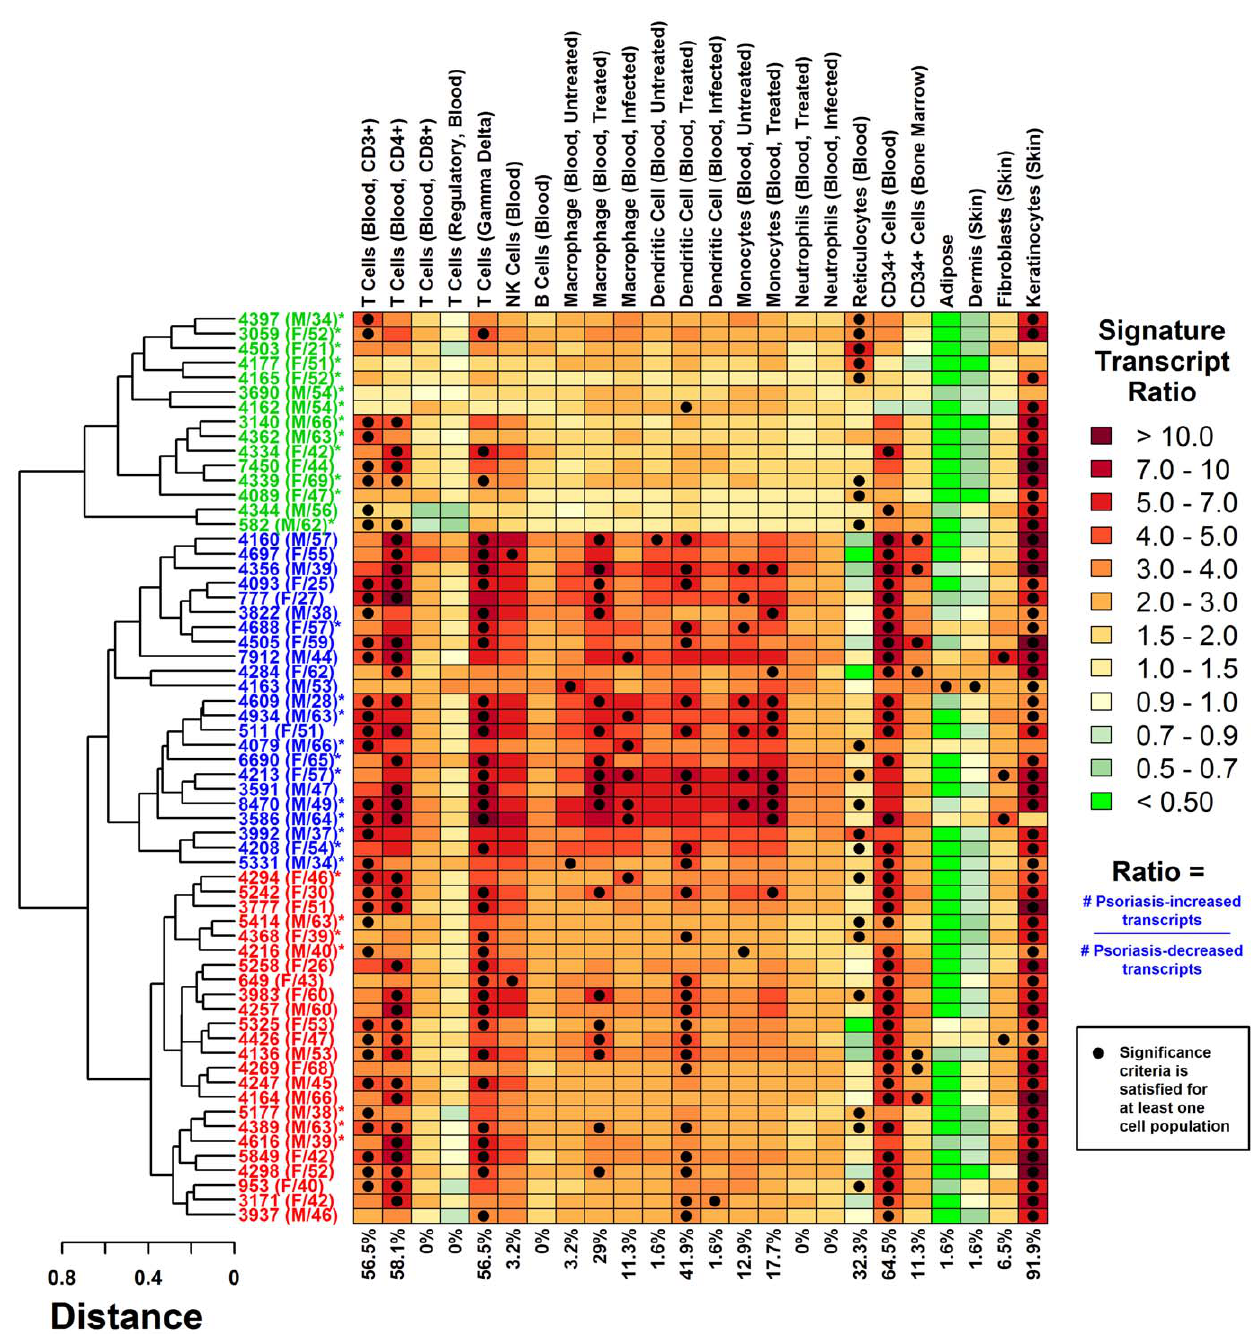
Figure 1. Sub-division of psoriasis lesions into strong, moderate and weak inflammatory groups based on genome-wide expression profiles. The heatmap displays intensity of inflammatory gene expression patterns in psoriatic plaques obtained from 62 subjects (rows) with respect to 24 different cell types (columns; immunocytes and dermal cells). Strong inflammatory signatures are denoted by blue subject labels (23/62 subjects), moderate signatures by red labels (24/62) and weak signatures by green labels (15/62). Lesional (PP) and non-lesional (PN) skin from each subject was analyzed by microarray to identify PP-increased and PP-decreased transcripts. Chart colors denote the behavior of 1000 ‘‘signature transcripts’’ associated with each cell population (see scale and Methods). Percentage values (bottom) denote the total fraction of subjects with a significant bias towards PP-increased expression among signature transcripts (black dots). Subject labels include a patient identifier with sex (M or F) and age. Asterisk symbols denote subjects with IL-13-weak gene expression signatures (see text and Figure 2). An expanded version of this figure is provided as supplemental material (Figure S1).